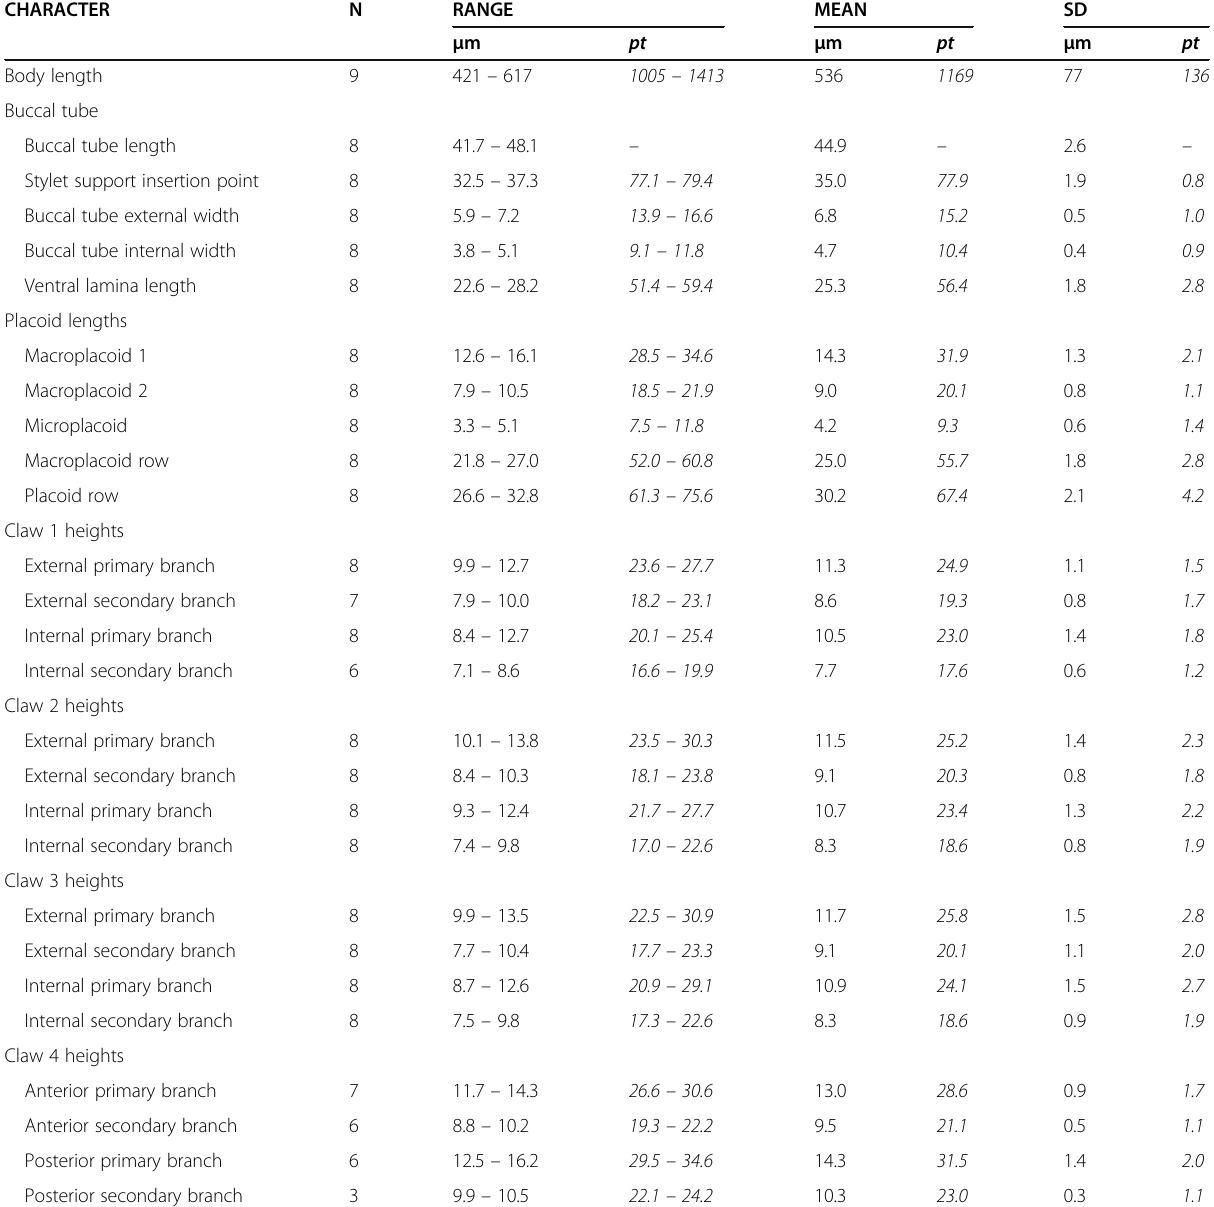
Table 6 Measurements [in μ m] of selected morphological structures of individuals of Macrobiotus pallarii Maucci, 1954 from the topotypic population (IT.337) mounted in Hoyer ’ s medium (N – number of specimens/structures measured, RANGE refers to the smallest and the largest structures among all measured specimens; SD – standard